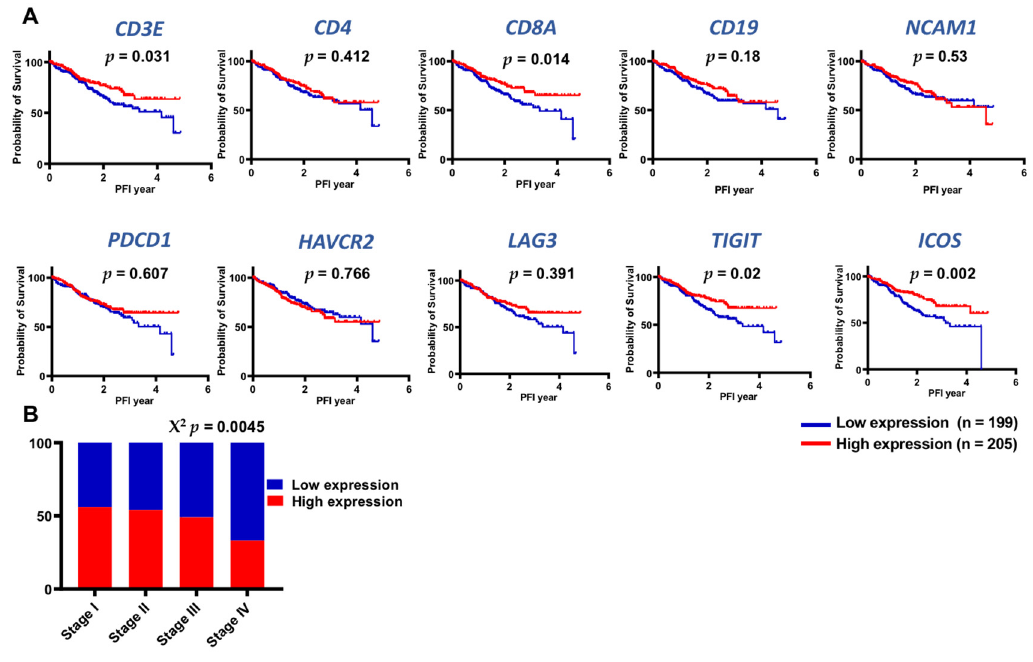
Figure 5. Evaluation of patient progression-free interval data for selected genes from TGCA COADREAD dataset. Kaplan- Meier curves for progression-free interval (PFI) were compared between patients with high (n = 205) and low (n = 199) gene expression of CD3E , CD4 , CD8A , CD19 , NCAM1 , PDCD1 , HAVCR2 , LAG3 , TIGIT , and ICOS ( A ). Distribution of patients with high and low gene expression of selected genes across different stages using Chi-squared ( χ 2 ) test (Stages I, II, III, and IV) ( B ).